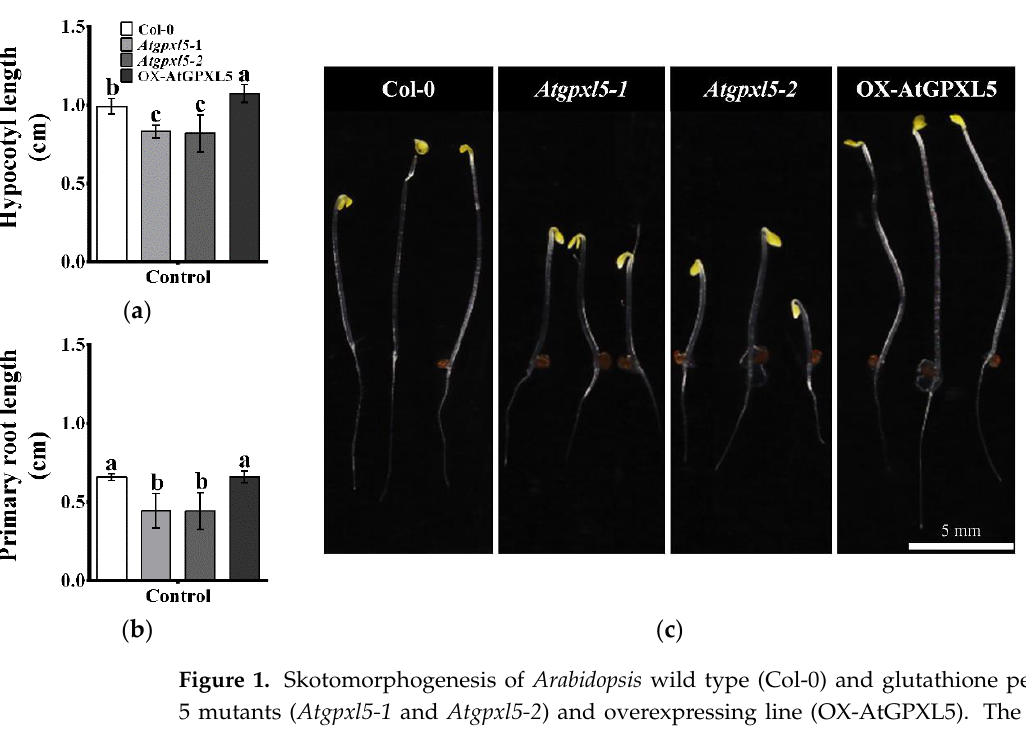
Figure 1. Skotomorphogenesis of Arabidopsis wild type (Col-0) and glutathione peroxidase-like 5 mutants ( Atgpxl5-1 and Atgpxl5-2 ) and overexpressing line (OX-AtGPXL5). The length of the hypocotyl ( a ) and primary root ( b ) of dark-grown seedlings and the overall phenotype of 4-day-old seedlings ( c ) germinated in dark. Mean ± SD, n = 15. Data were analysed using one-way ANOVA followed by Duncan’s test. Different letters represent data considered statistically significant at p ≤ 0.05.